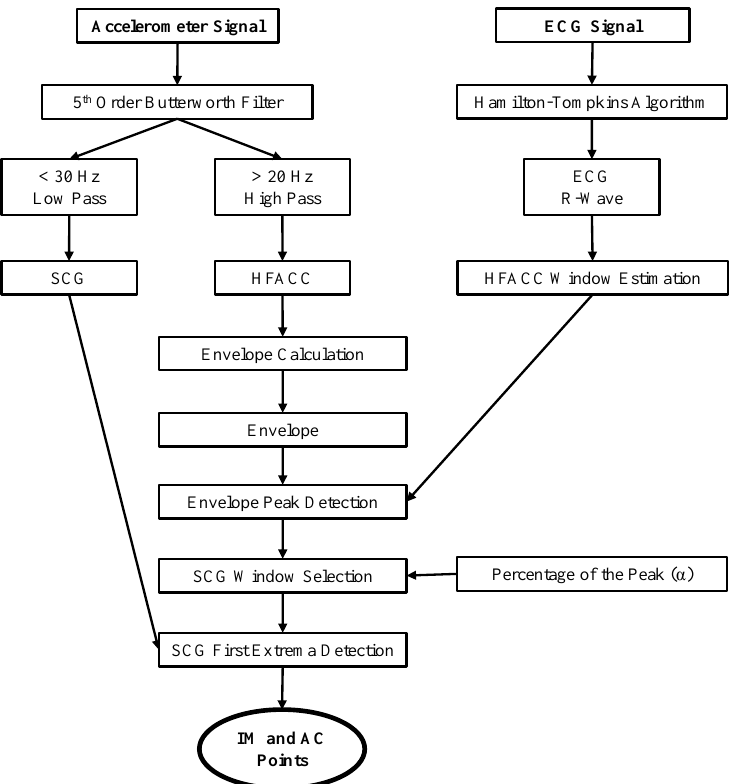
Figure 7. Process of detecting AC and IM